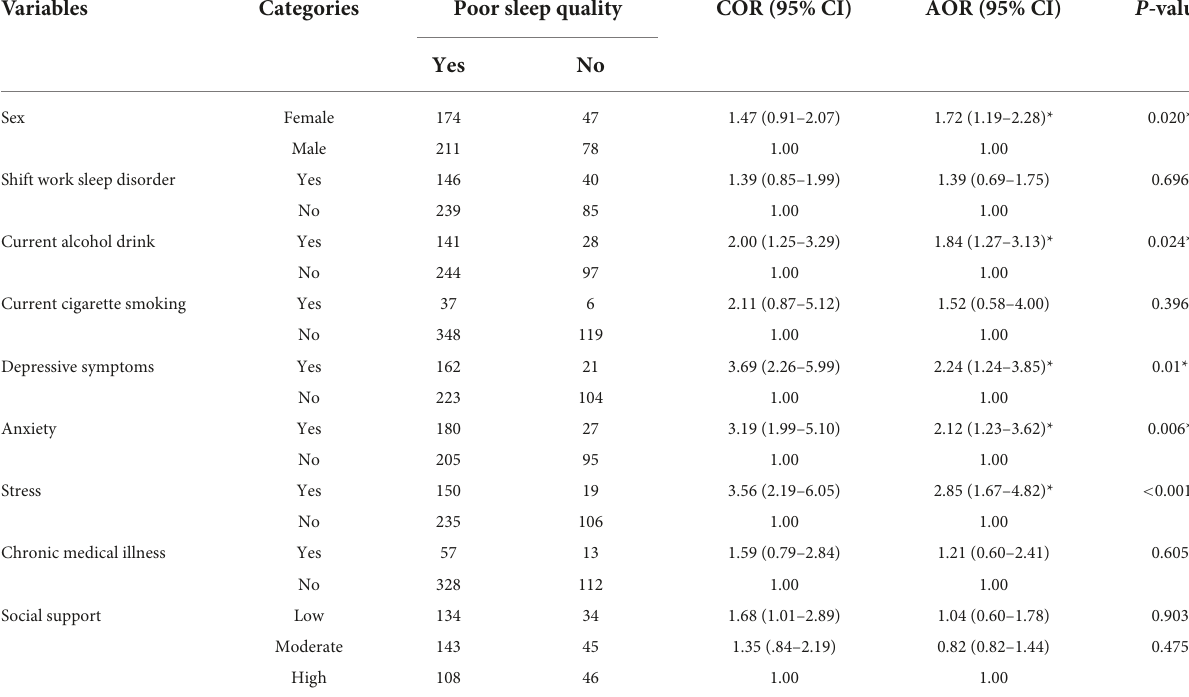
TABLE 5 Bi-variables and multi-variables regression analysis between poor sleep quality and explanatory variables among nurses working at comprehensive specialized hospitals in Northwest Ethiopia,